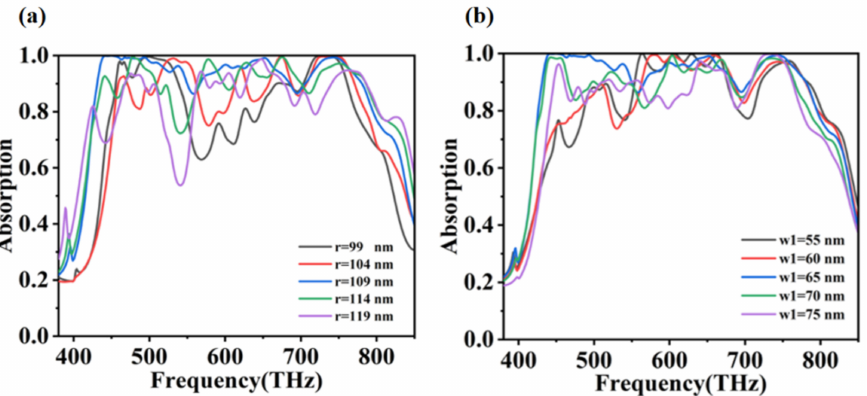
Figure 8. ( a ) Absorption spectrum when varying the disk radius r (99–119 nm) at 380–830 THz. ( b ) Absorption spectrum of varying the slot width w1 (55–75 nm) at 380–830